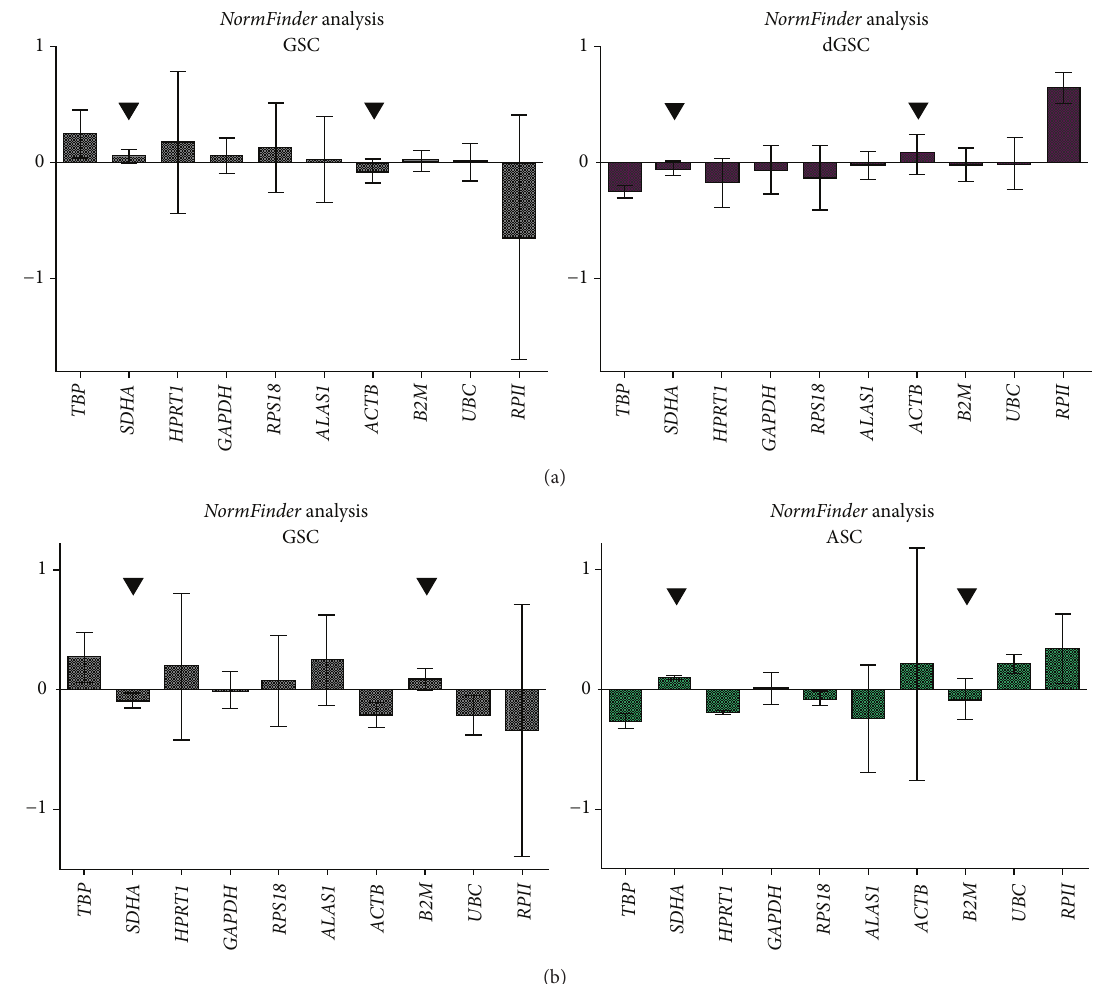
Figure 6: Determination of the most stable reference genes with NormFinder For GSC versus dGSC (a) and GSC versus ASC (b). Bars represent intergroup variances, while error bars represented the average of intragroup variances. Ideal reference gene had intergroup variation as close to zero as possible and error bars as small as possible. Table 7: Final ranking of HKGs.